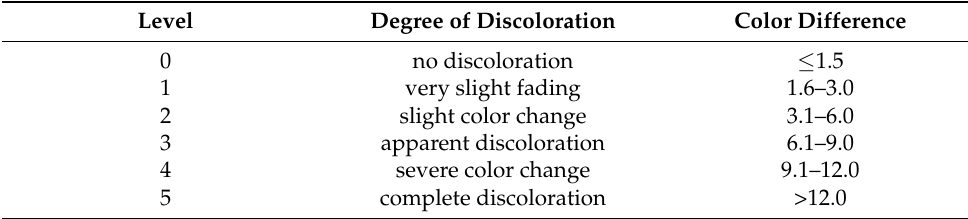
Figure 9. Coatings color changes of the samples after contact with liquids. The numbers above the columns are representative of the levels in Table 4. Table 4. Color difference values corresponding to the level of